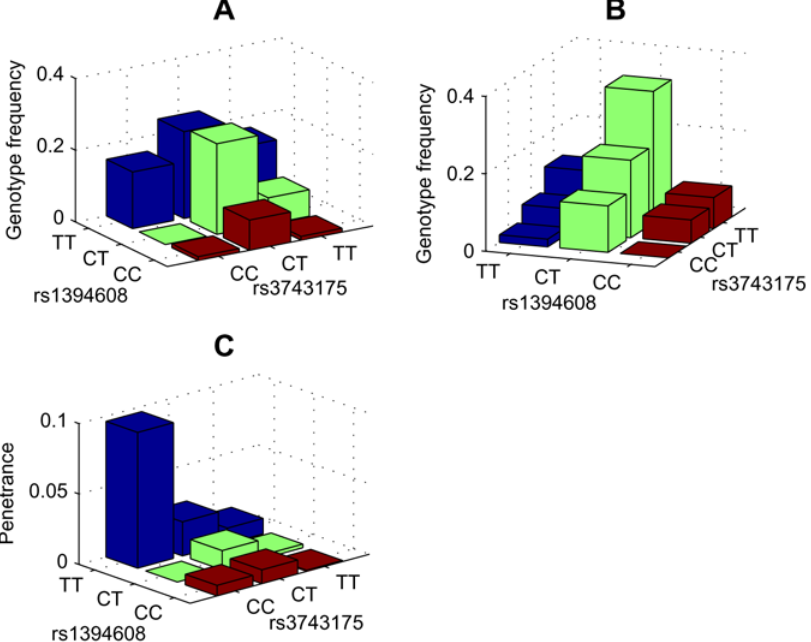
Figure 8. Distributions of genotypes of rs1394608 and rs3743175 in the AMD data set and the penetrance estimated for combinatory genotypes of these two SNPs. (A) The distribution of genotypes of rs1394608 and rs3743175 in the case population. (B) The distribution of genotypes of rs1394608 and rs3743175 in the control population. (C) The estimated penetrance for the combination of rs1394608 and rs3743175, assuming that the disease prevalence is 0.01. The relative values for the penetrance maintain the same when the population prevalence is alternatively assumed. It is shown that rs1394608 could be seen as the dominant-effect locus for the disease risk, and its effect is strongly regulated by